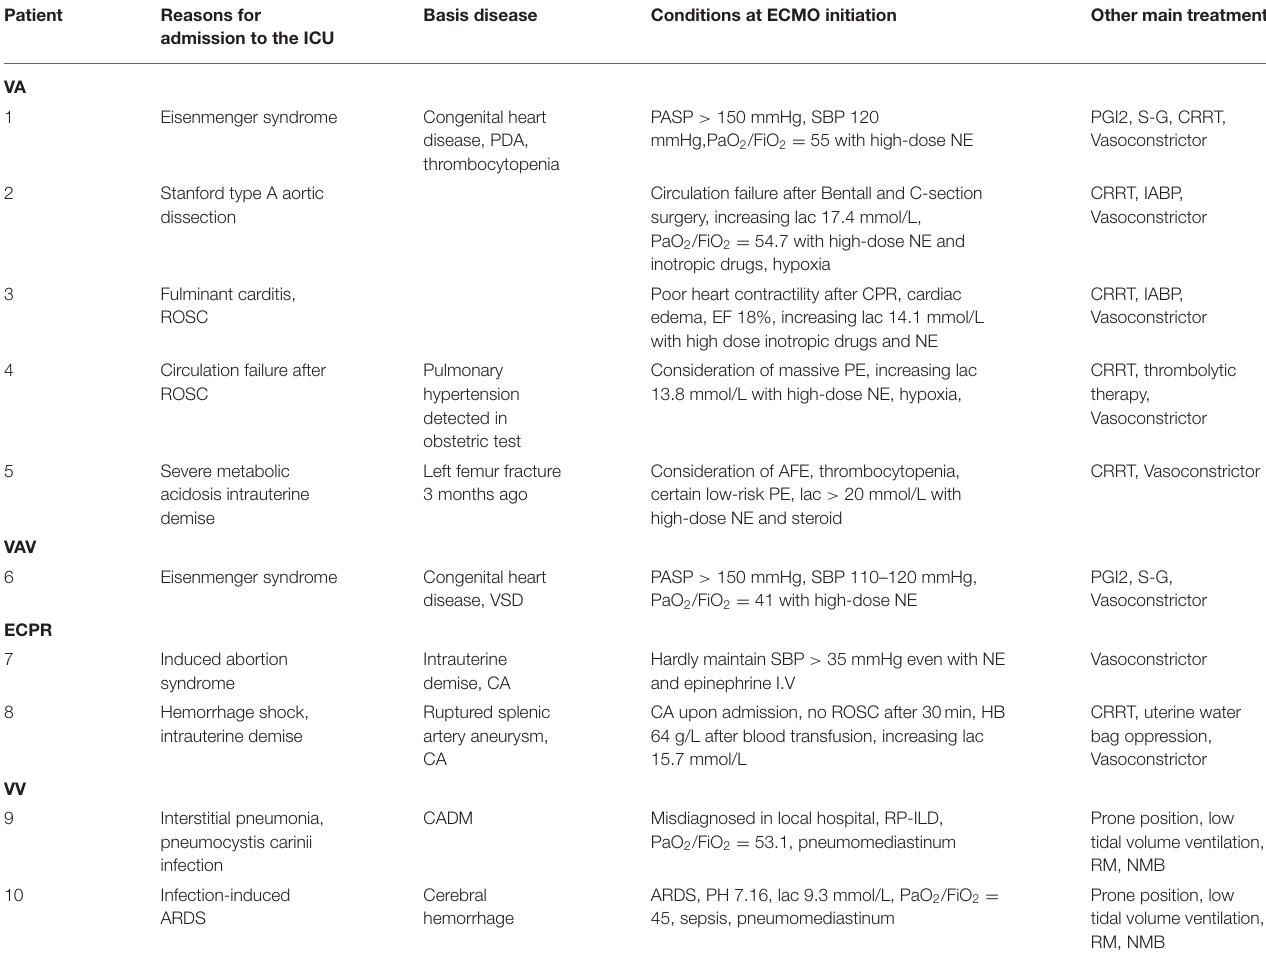
TABLE 2 | Information of patient disease.